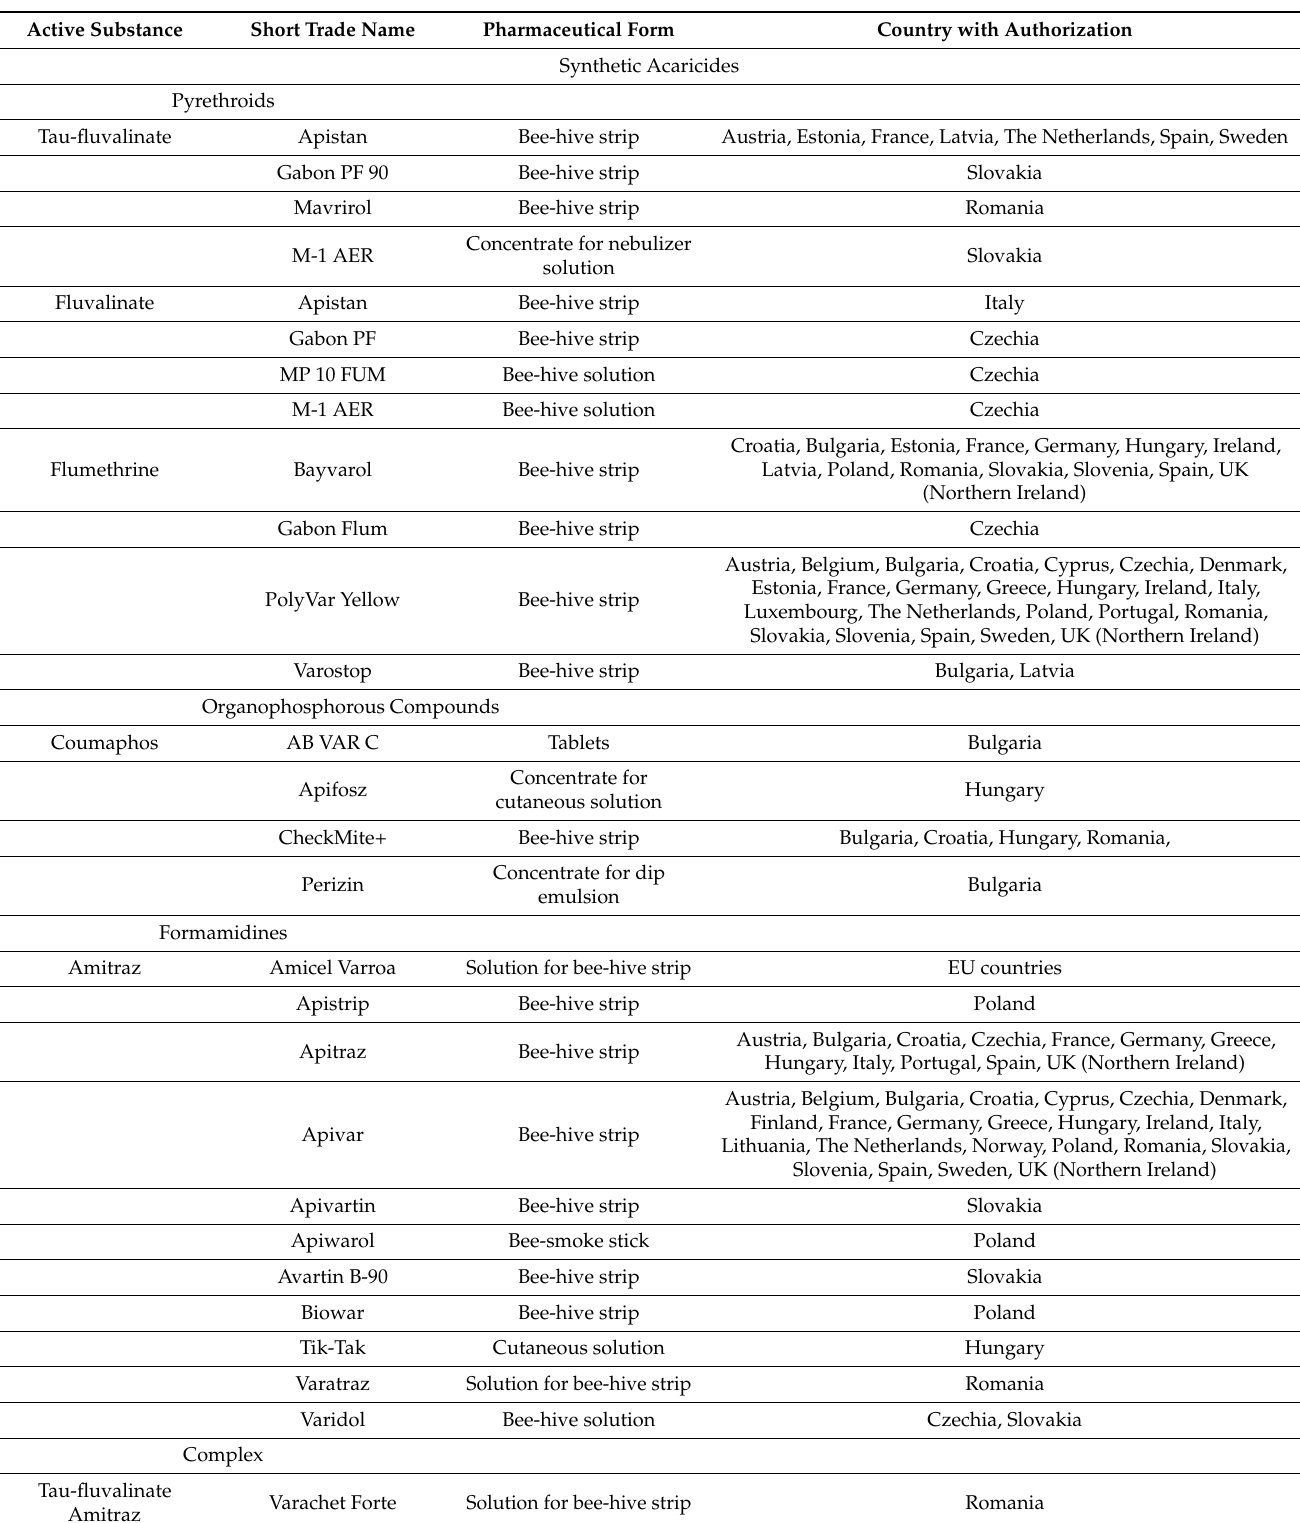
Table 1. VMPs for honey bees authorized for use in EU/EEA